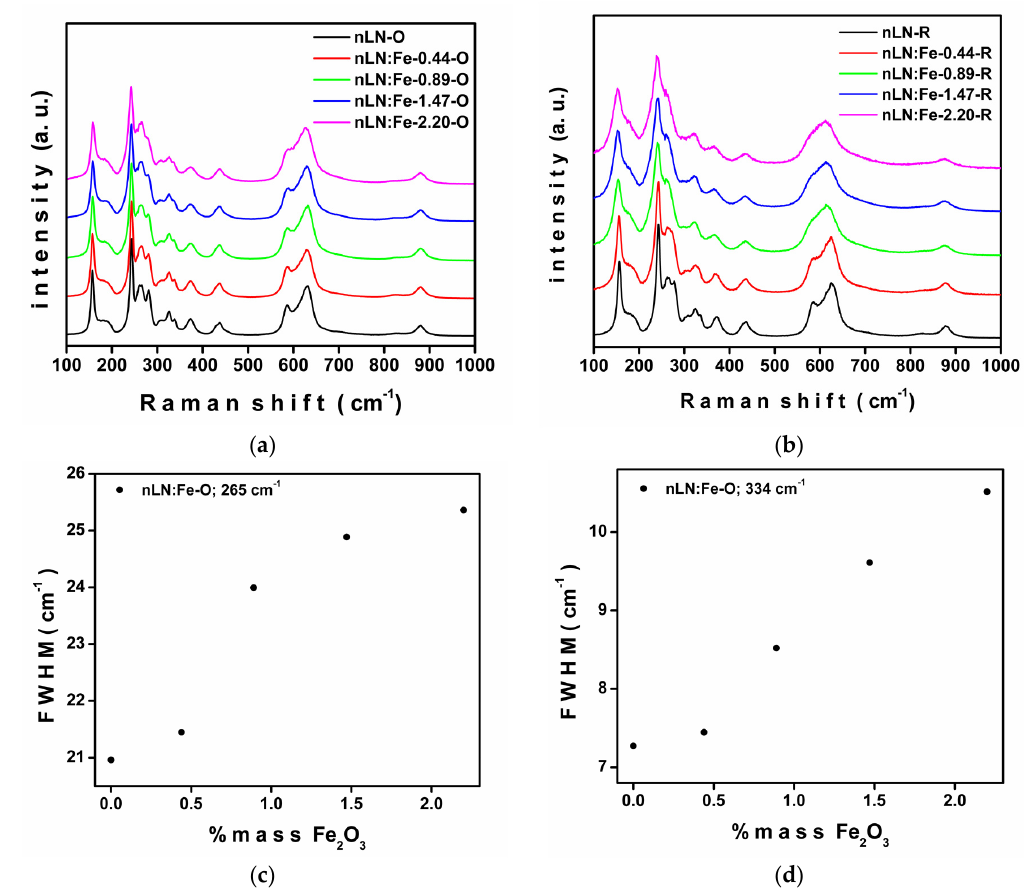
Figure 4. Raman spectra of samples obtained after Fe-doping and application of thermal treatments TTAH and TTAO: ( a ) Oxidized samples (TTAO); ( b ) Reduced samples (TTAH); ( c ) Calculated FWHM’s for peaks around 265 cm − 1 (oxidized samples); ( d ) Calculated FWHM’s for peaks around 334 cm − 1 (oxidized samples).